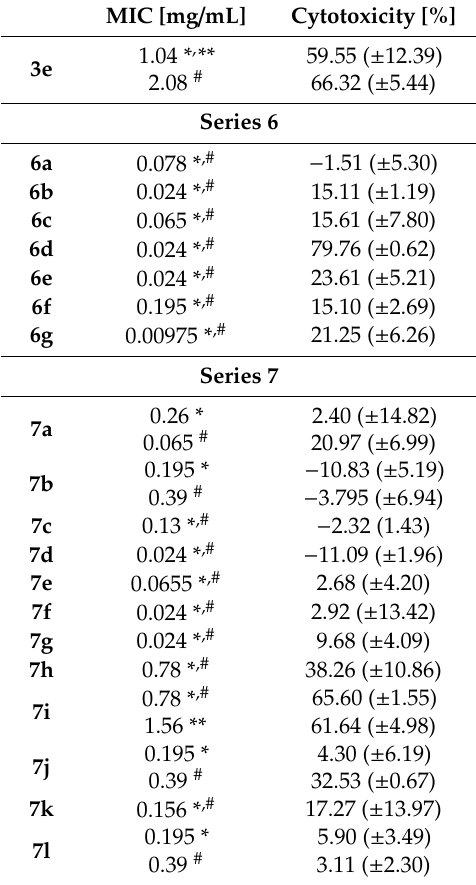
Table 6. Cytotoxicity of MIC of 1,2-benzothiazine